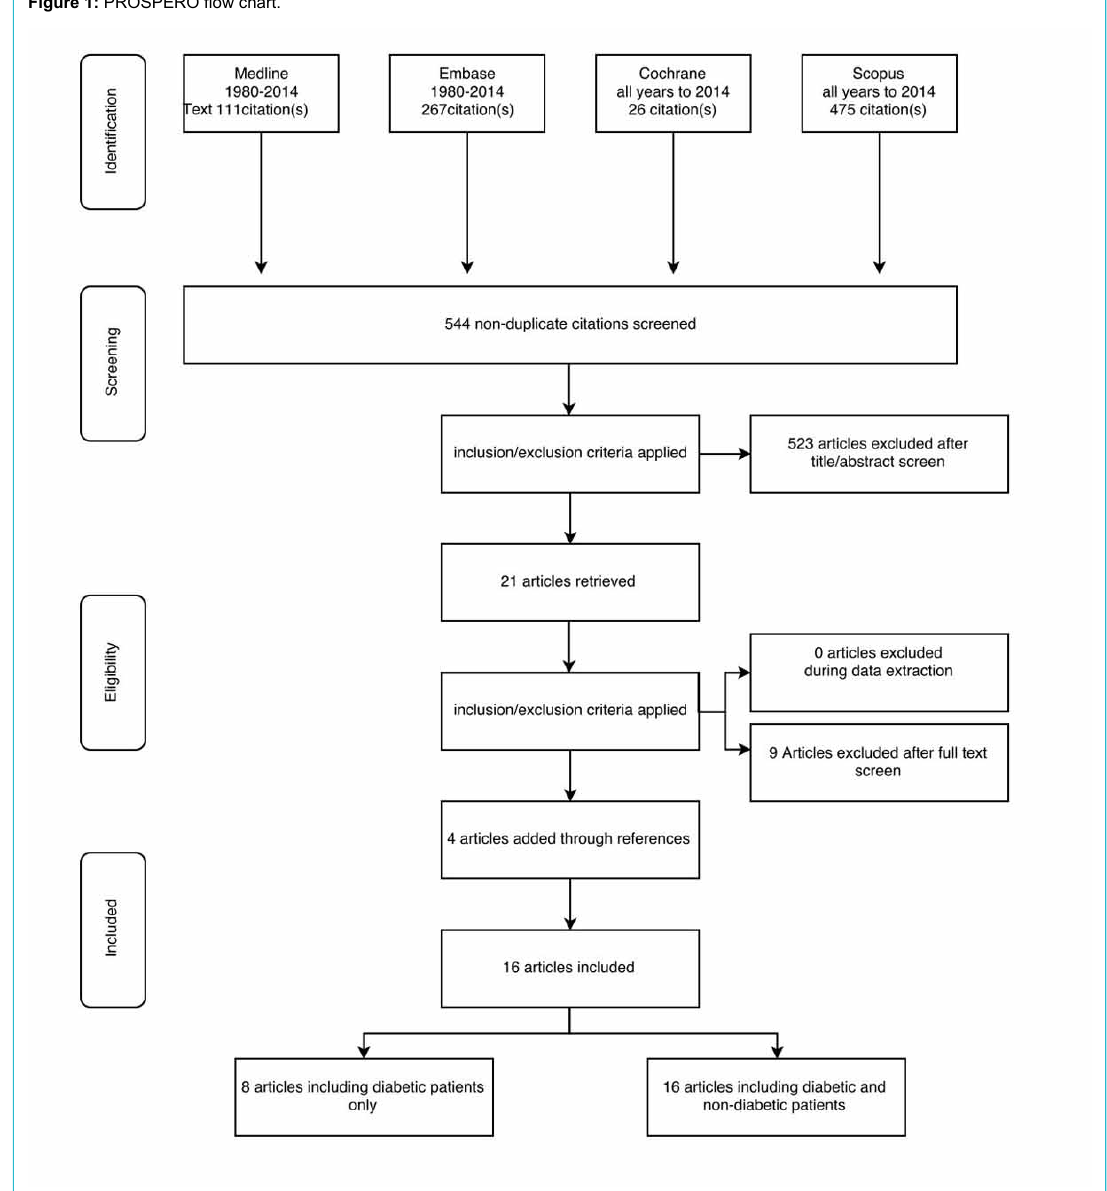
Figure 1: PROSPERO flow